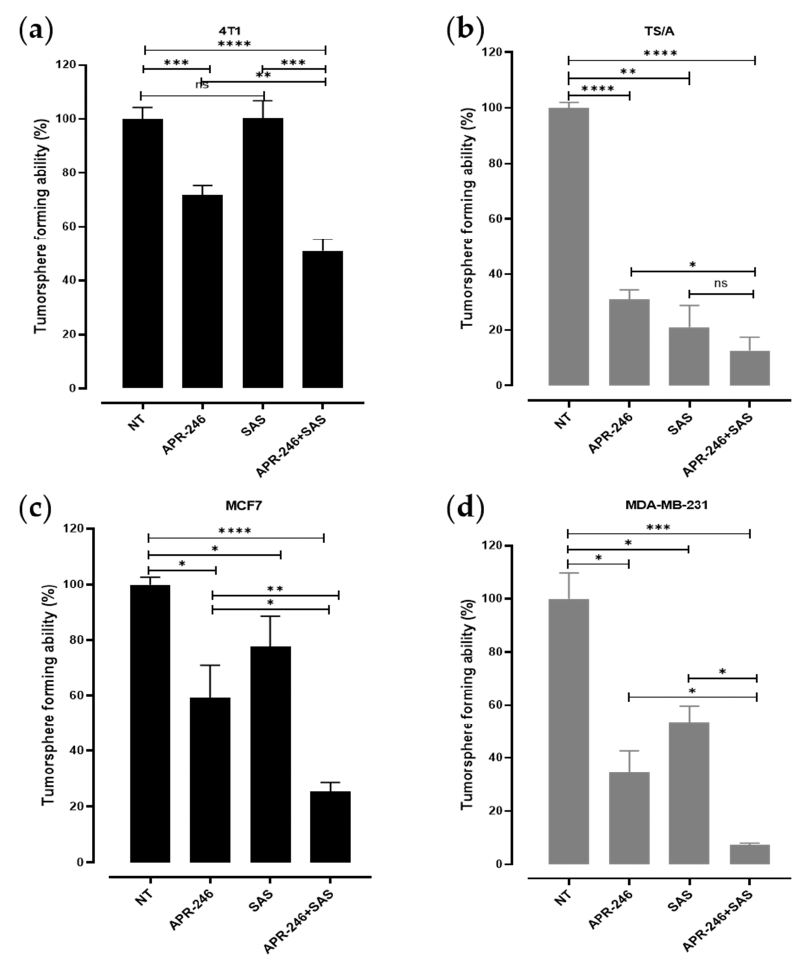
Figure 3. Effect of SAS and APR-246 on tumorsphere generation. Histograms showing the sphere- forming ability of ( a ) 4T1, ( b ) TS/A, ( c ) MCF7, and ( d ) MDA-MB-231 tumor cells treated with APR-246 5 µM, SAS 150 µM, or the combination of the two compounds. Values of treated cells represent the percentage of the tumorsphere-forming ability in comparison to the mean value of the cells cultured in the medium alone, indicated as NT (= not treated), considered as 100%. * p ≤ 0.03; ** p = 0.001; *** p = 0.0001; **** p < 0.0001; ns = not significant; Student’s t test.